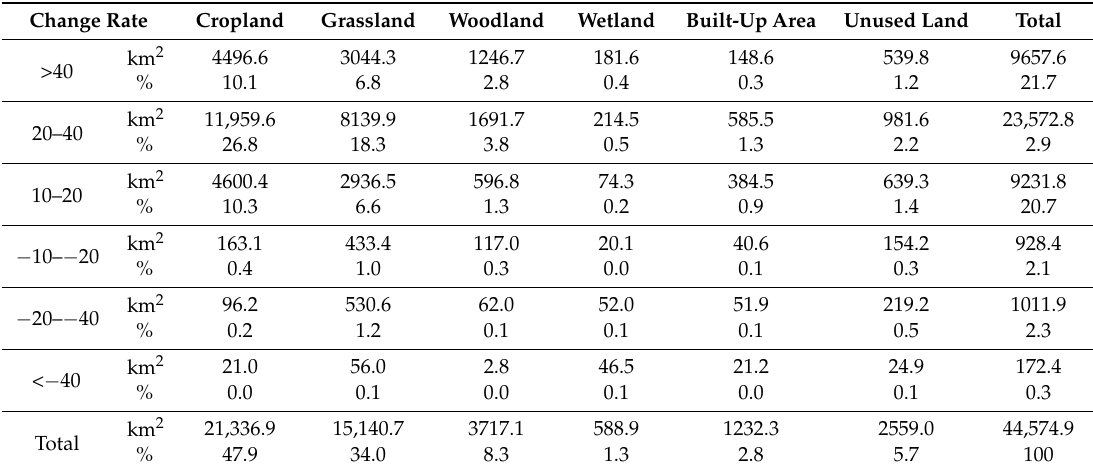
Table 3. Area of trend land cover changes with different change rates related to land cover